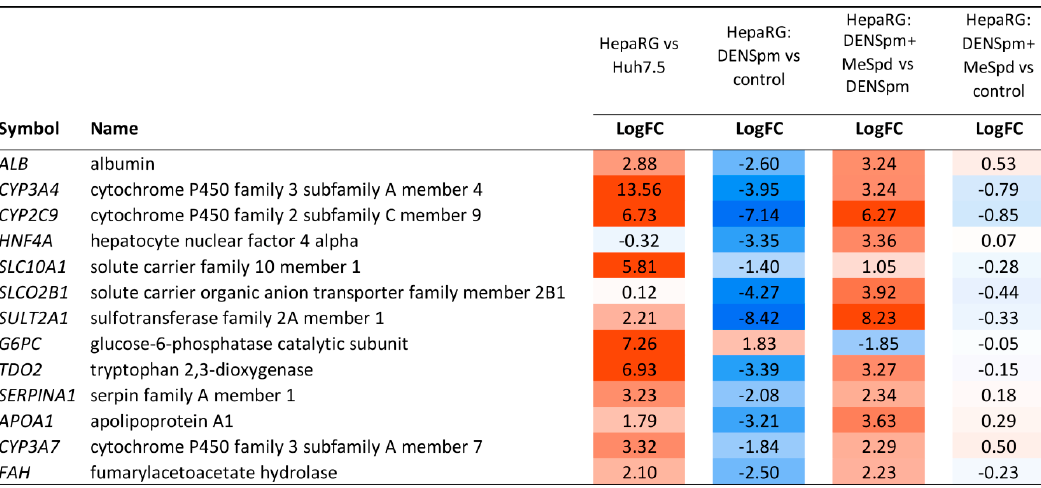
Figure 8. Expression of mature hepatocyte markers in four comparisons: (a) HepaRG vs. Huh7.5 cells (HepaRG vs. Huh7.5); (b) DENSpm-treated HepaRG vs. non-treated HepaRG cells (HepaRG: DENSpm vs. control); (c) DENSpm+MeSpd-treated HepaRG cells vs. DENSpm-treated HepaRG (HepaRG: DENSpm+MeSpd vs. DENSpm); (d) DENSpm+MeSpd-treated HepaRG cells vs. non-treated HepaRG cells (HepaRG: DENSpm+MeSpd vs. control). LogFC—binary logarithm of expression level fold change.